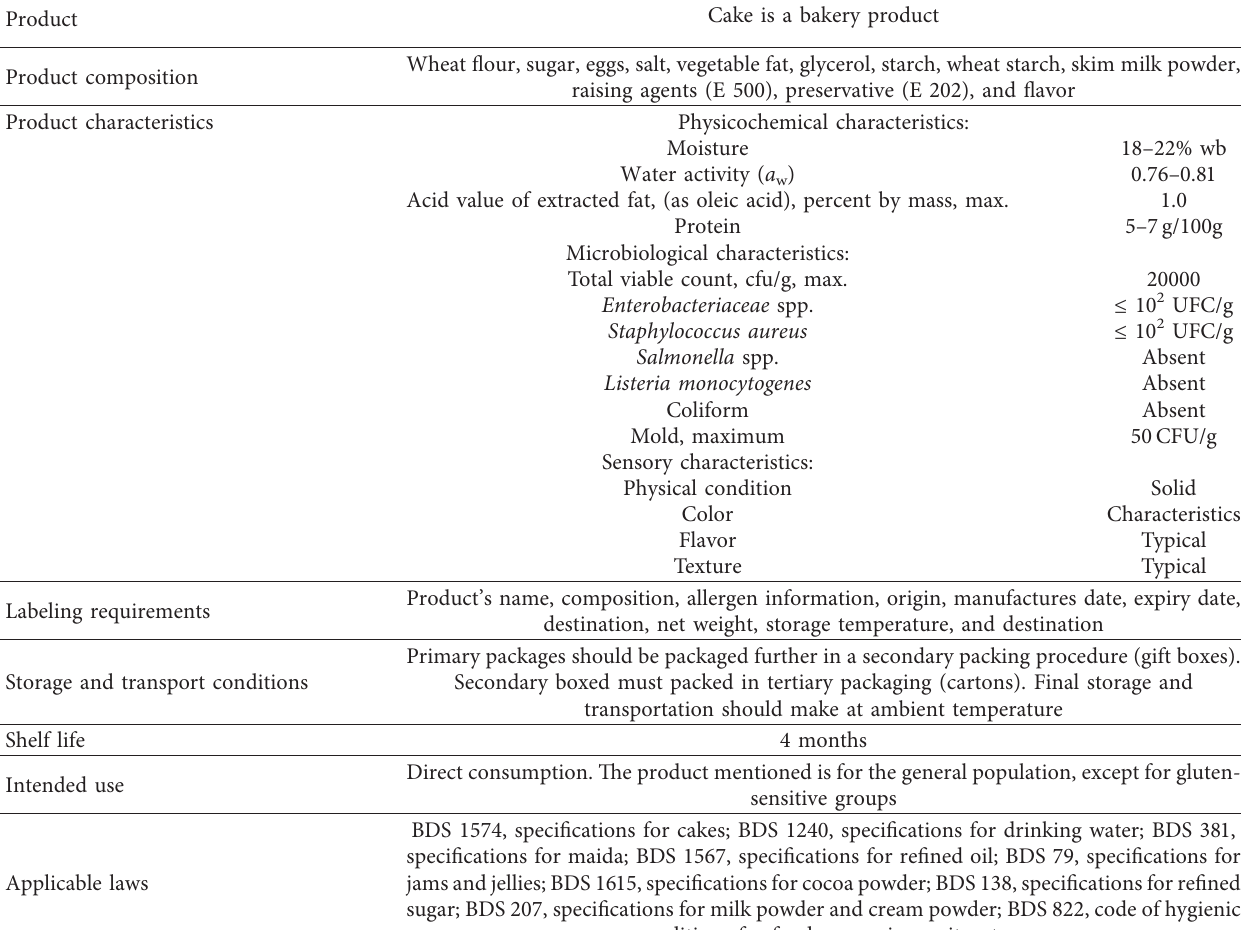
Table 1: Product description and intended